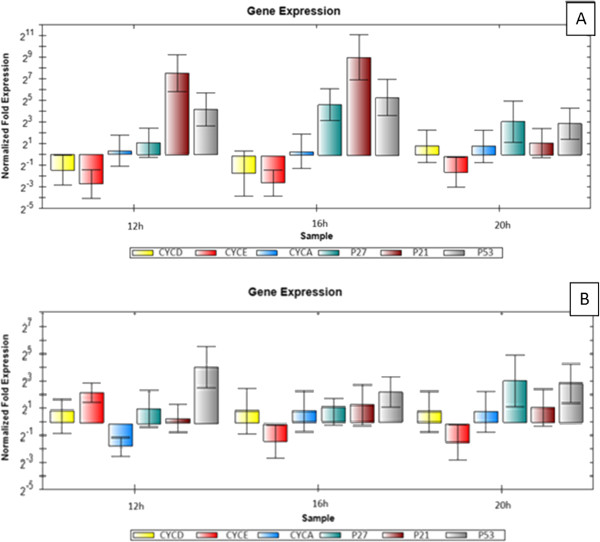
Real-time quantitative PCR analysis illustrates the gene expression in (A) HeLa cells and (B) HepG2 cells after 12, 16, and 20 h of treatment with the IC50 of MBS extract. The gene expression was normalized with the reference gene (β-actin). The relative quantification of the target genes, Cyclin D (CYCD), Cyclin E (CYCE), Cyclin A (CYCA), p27, p21, and p53, by the delta–delta–Ct method was done using the software BIO-RAD CFX Manager (V 1.1.308).